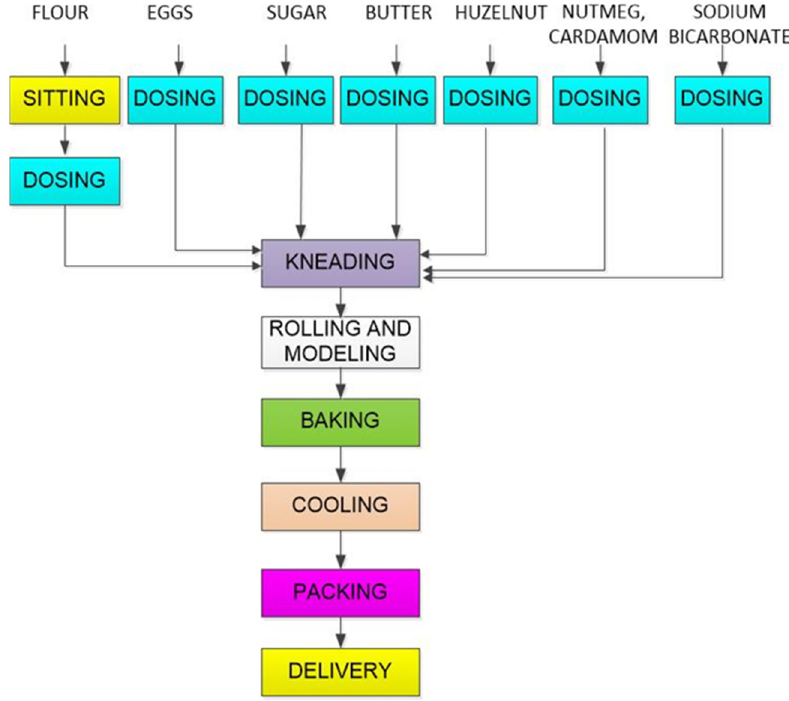
Figure 2. The technological scheme for obtaining biscuits.